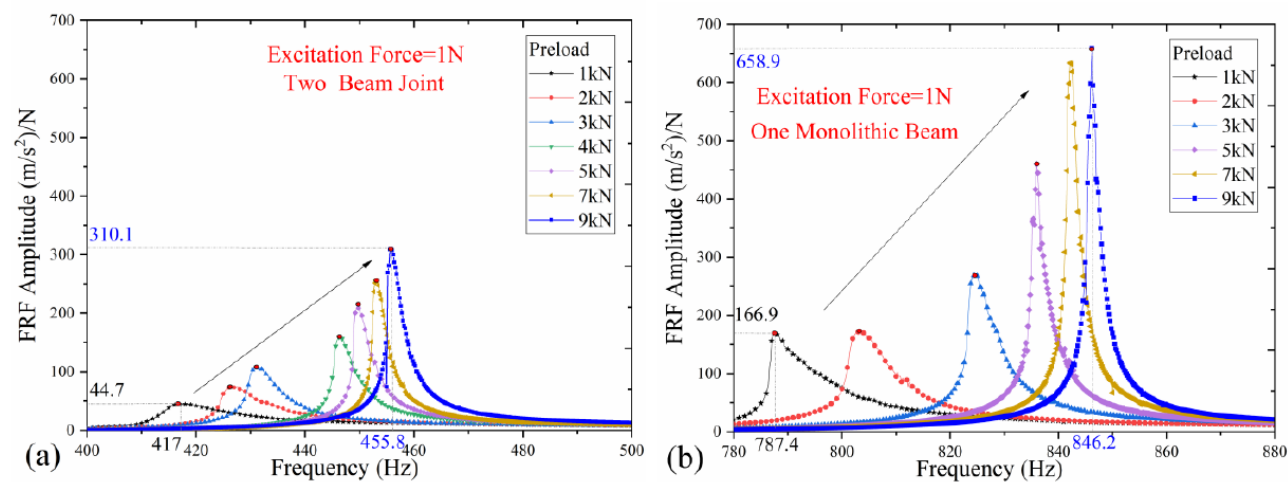
Figure 15. Modal damping ratios for different excitation force amplitudes (bolt tension = 5 kN).